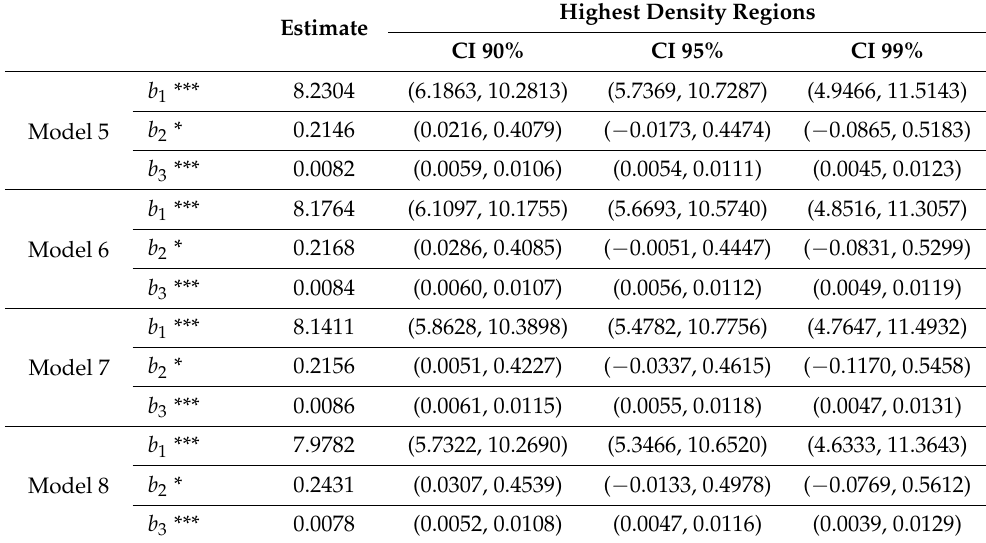
Table 6. Results for Model 5 to Model 8 (data from 1990 to